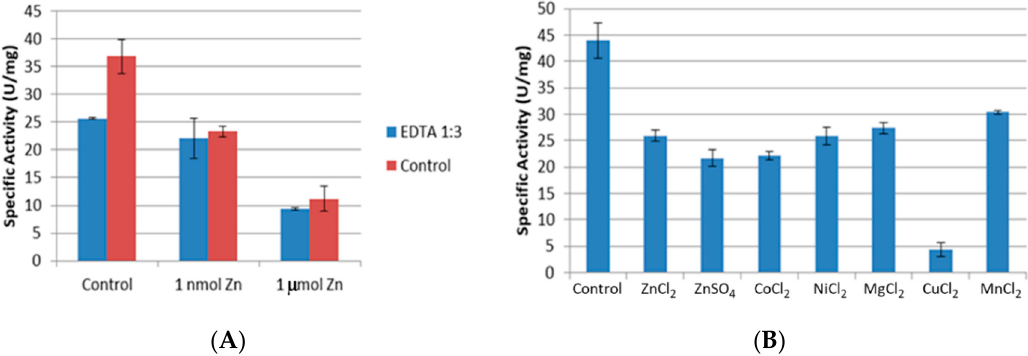
Figure 3. Effect of Zn 2+ and other divalent metals on activity of CpCR. ( A ) Effect of Zn 2+ (ZnSO 4 ) on CpCR activity at various concentrations; ( B ) Specific activity of CpCR influenced by various divalent metal ions.